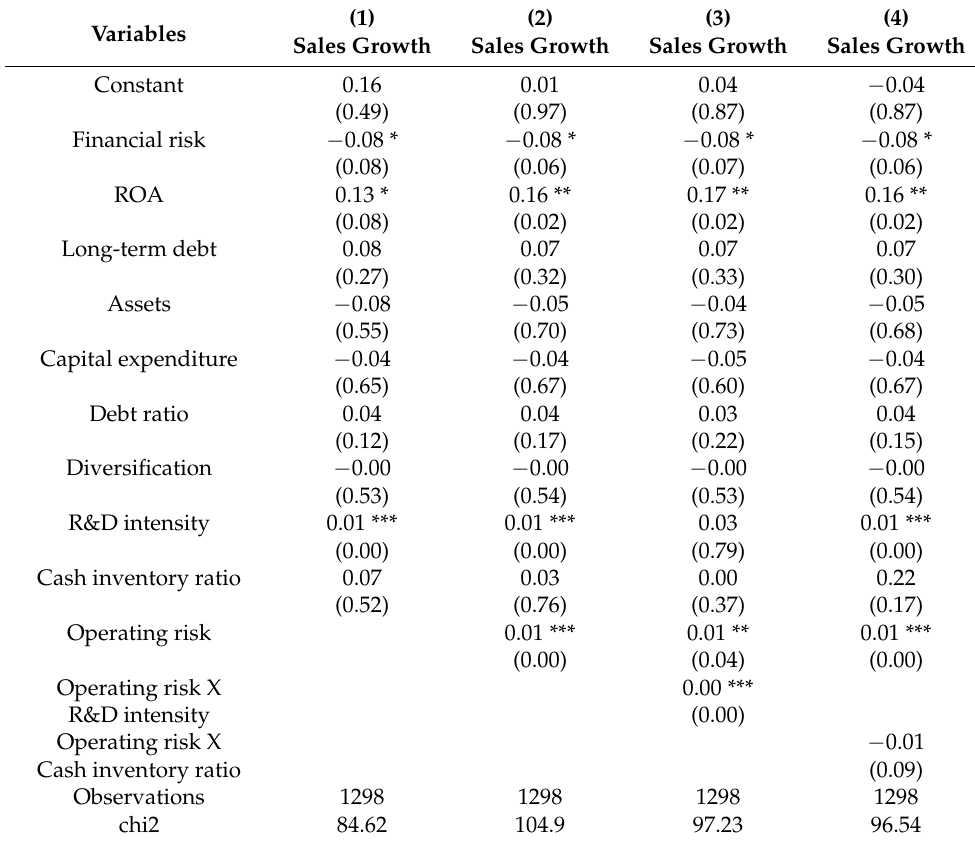
Table 5. Robustness check #3—Feasible generalized least squares